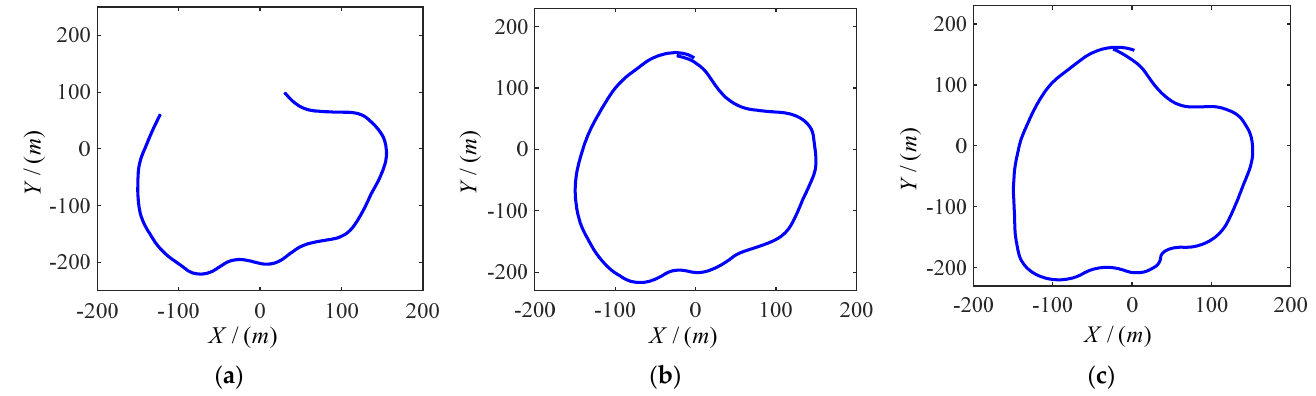
Figure 7. Vehicle real travel trajectories. ( a ) The track at moderate and low speed; ( b ) track at moderate and high speed; ( c ) track at high